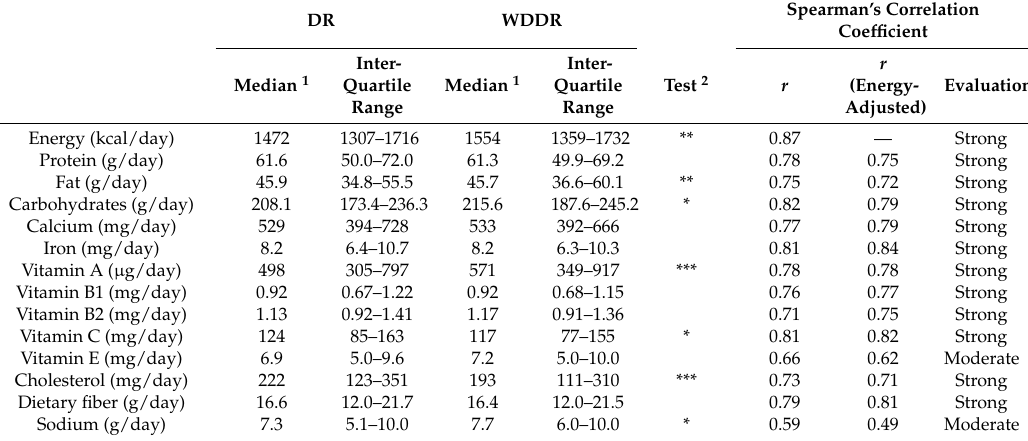
Table 2. Comparison and correlation of the DR and WDDR by energy and nutrient intake ( n =